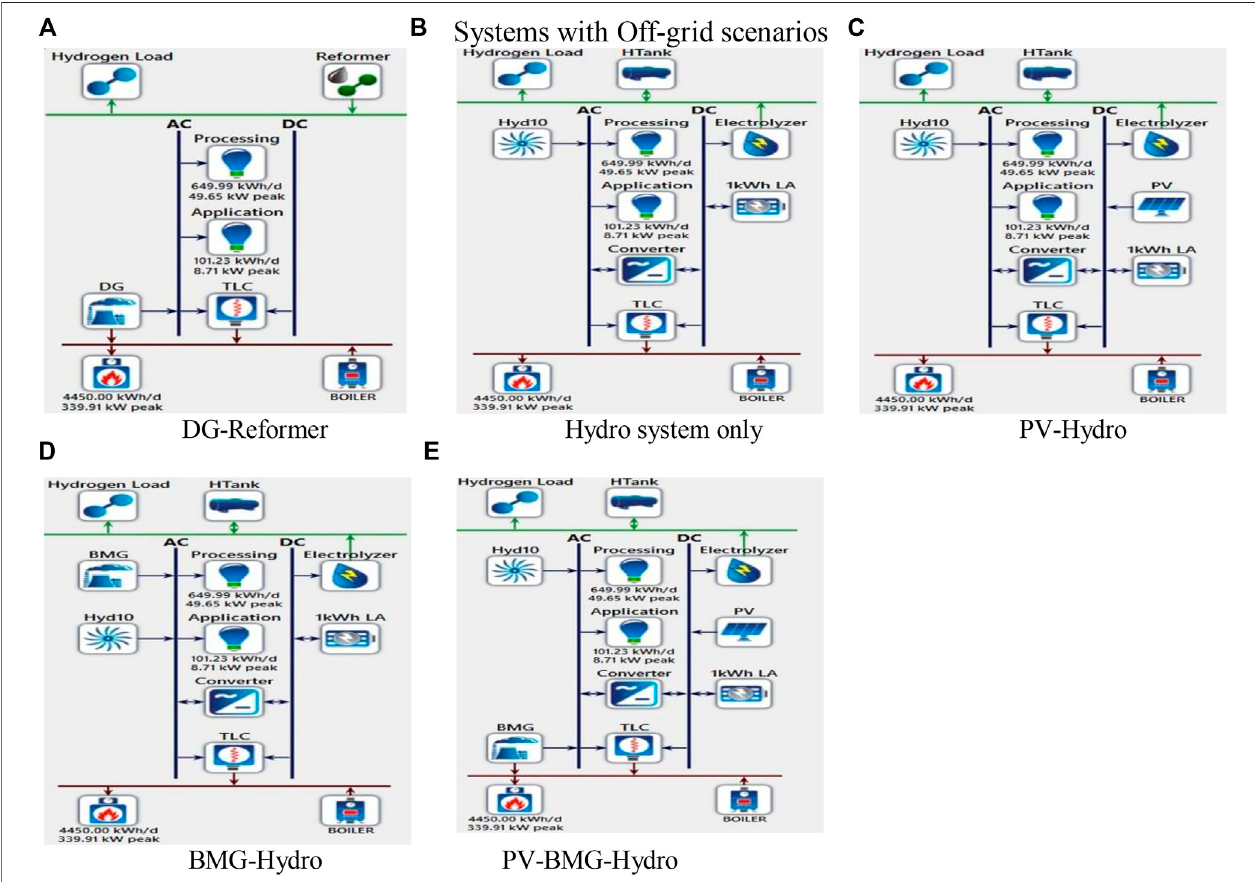
FIGURE5| Designsofstandaloneandgridhybridrenewableenergytechnologies. (A) DG-reformer. (B) Hydrosystemonly. (C) PV-hydro. (D) BMG-hydro. (E) PV- BMG-hydro. (F) Grid-DG-reformer. (G) Grid-hydro. (H) Grid-PV-hydro. (I) Grid-BMG-hydro. (J)